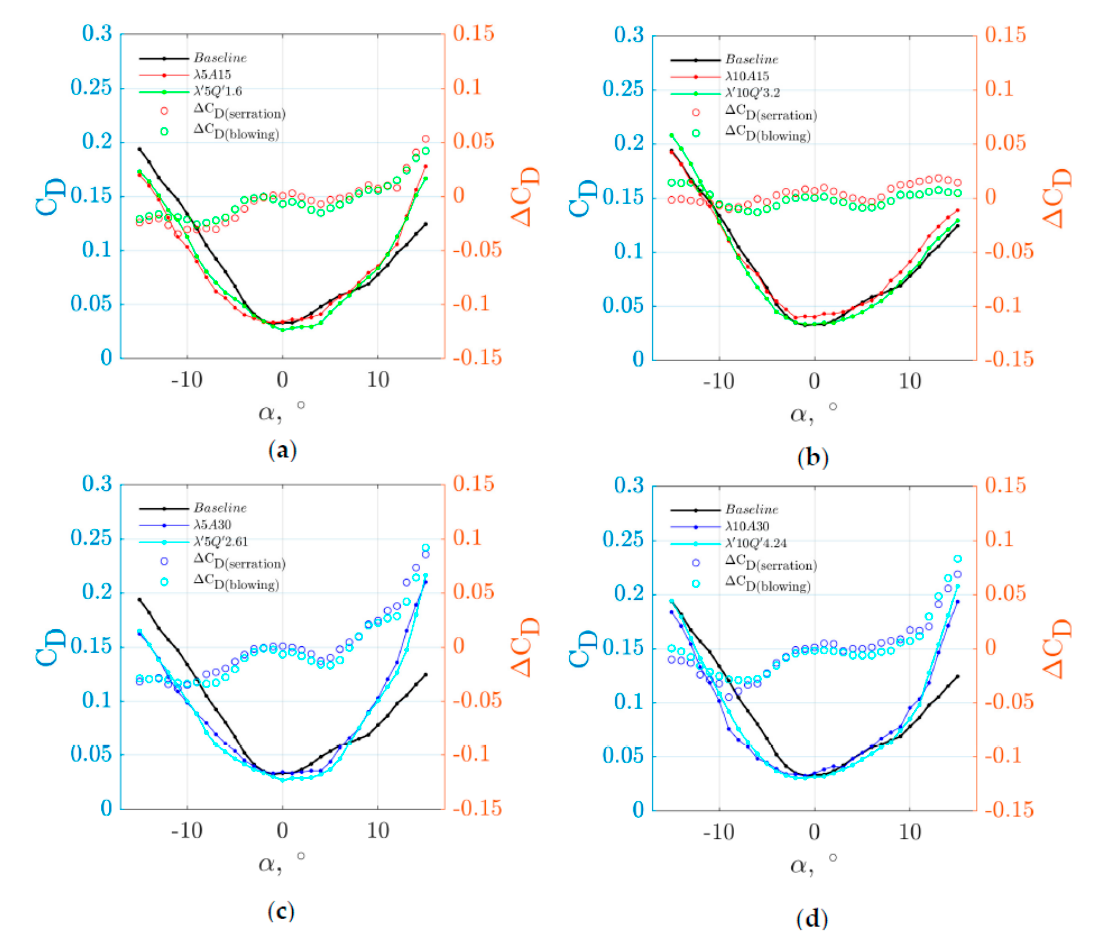
Figure 6. Comparison of the drag coefficient C D and Δ C D as a function of angle of attack α produced by serrated and blowing leading edges at U = 24 ms − 1 .